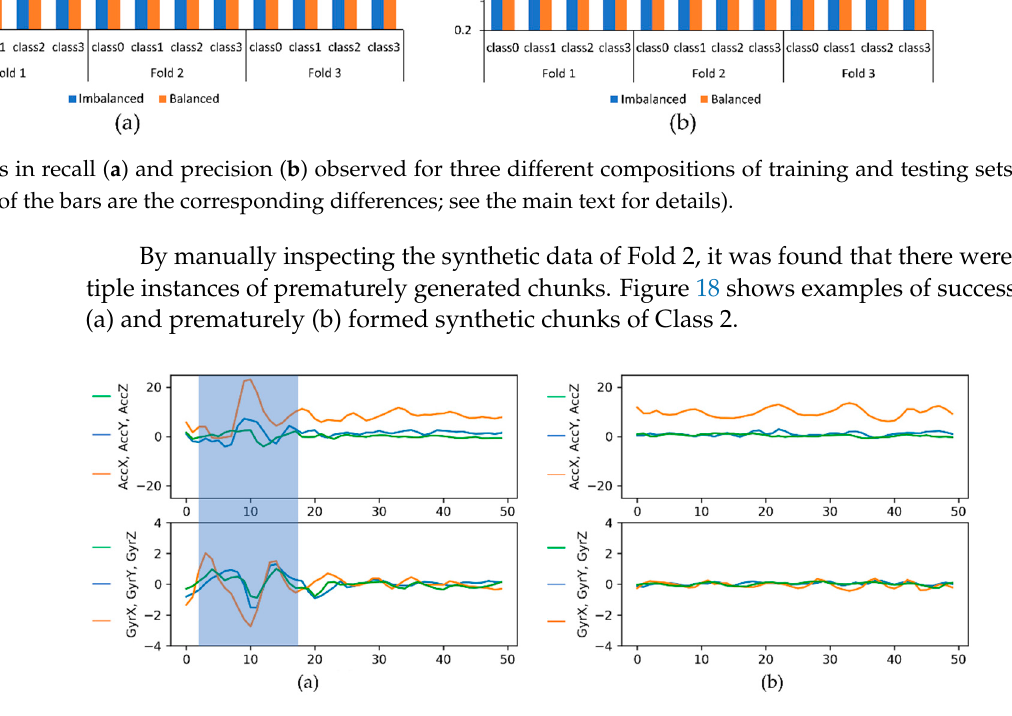
Figure 18. Class 2 synthetic chunks generated by the Unrolled GAN: ( a ) successfully formed (the signal pattern corresponding to a speed bump is highlighted) and ( b ) prematurely